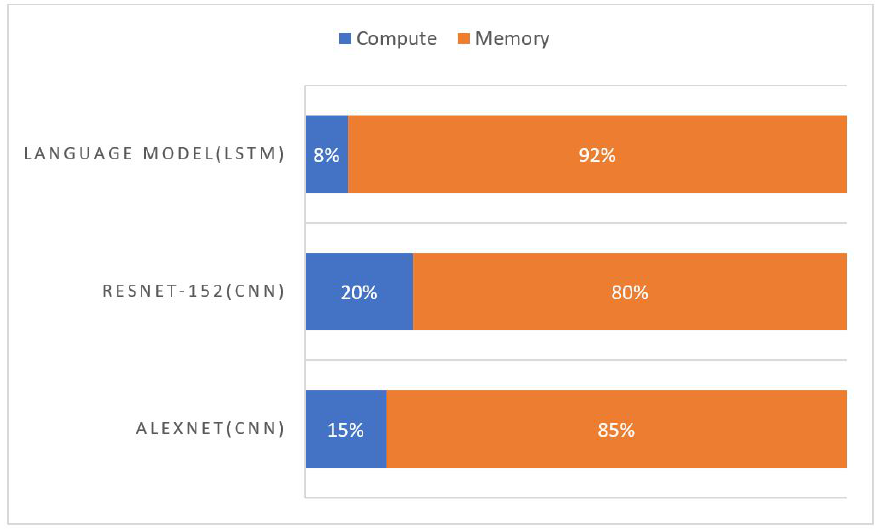
Figure 5. The percentage of Memory for CNN model’s